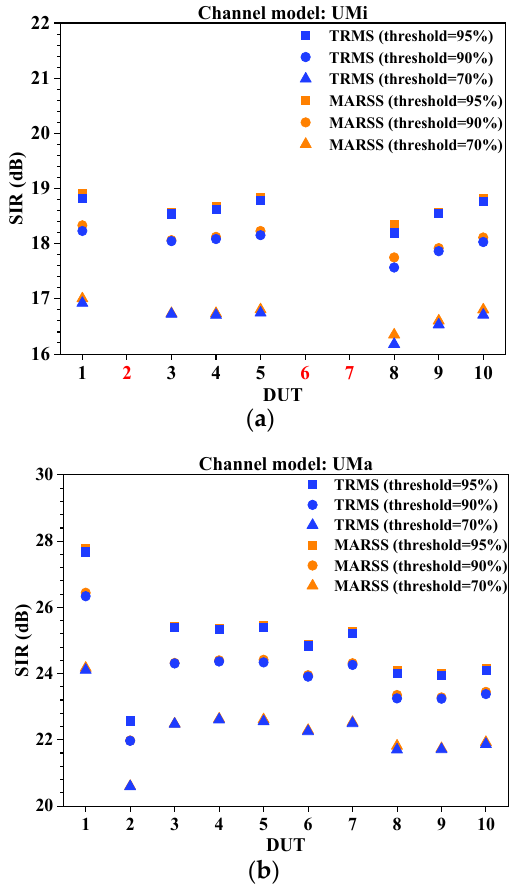
Figure 9. A comparison between the different average manners for ( a ) the UMi and ( b ) the UMa channel model under CTIA interference-limited environmental condition (MARSS raw data).